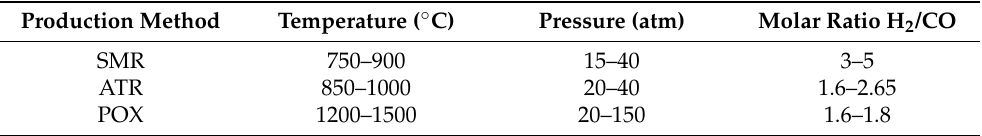
Table 1. Comparative characteristics of the three most common methods for producing syngas and hydrogen